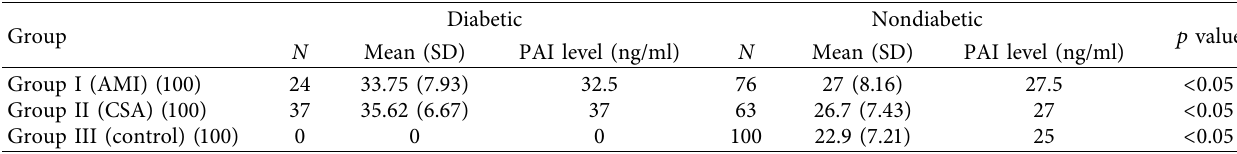
Table 2: PAI level (ng/nl) in diabetic and nondiabetic cases.